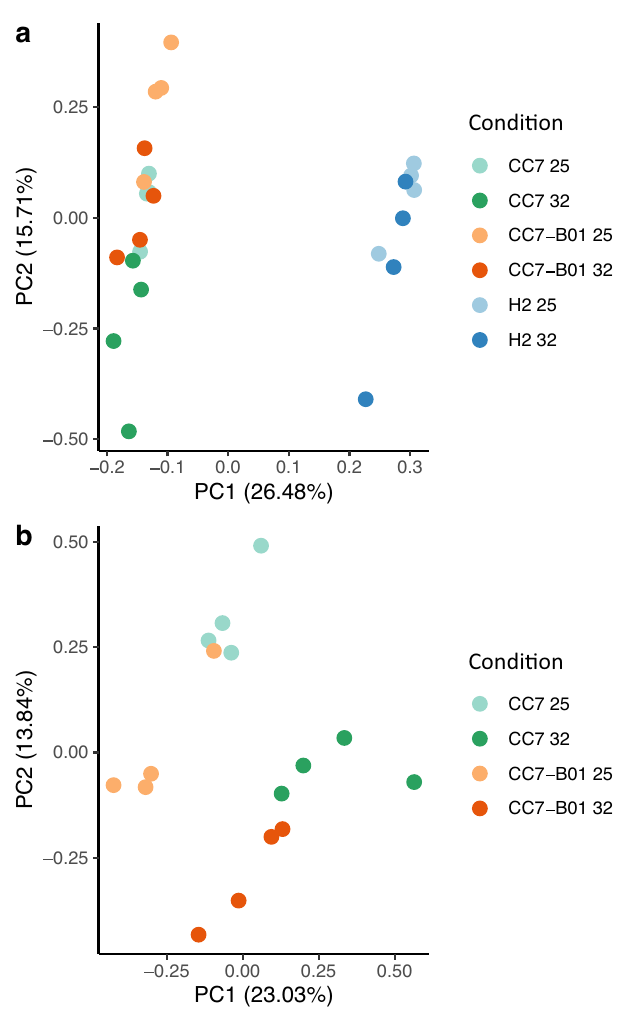
Fig. 1 Principal component analysis of transcriptomic pro fi les at control and stress conditions. a Analysis of all three samples transcriptomic pro fi les under control (25 °C) and heat stress (32 °C). b Analysis focusing only on CC7 and CC7-B01, to test the separation between control and